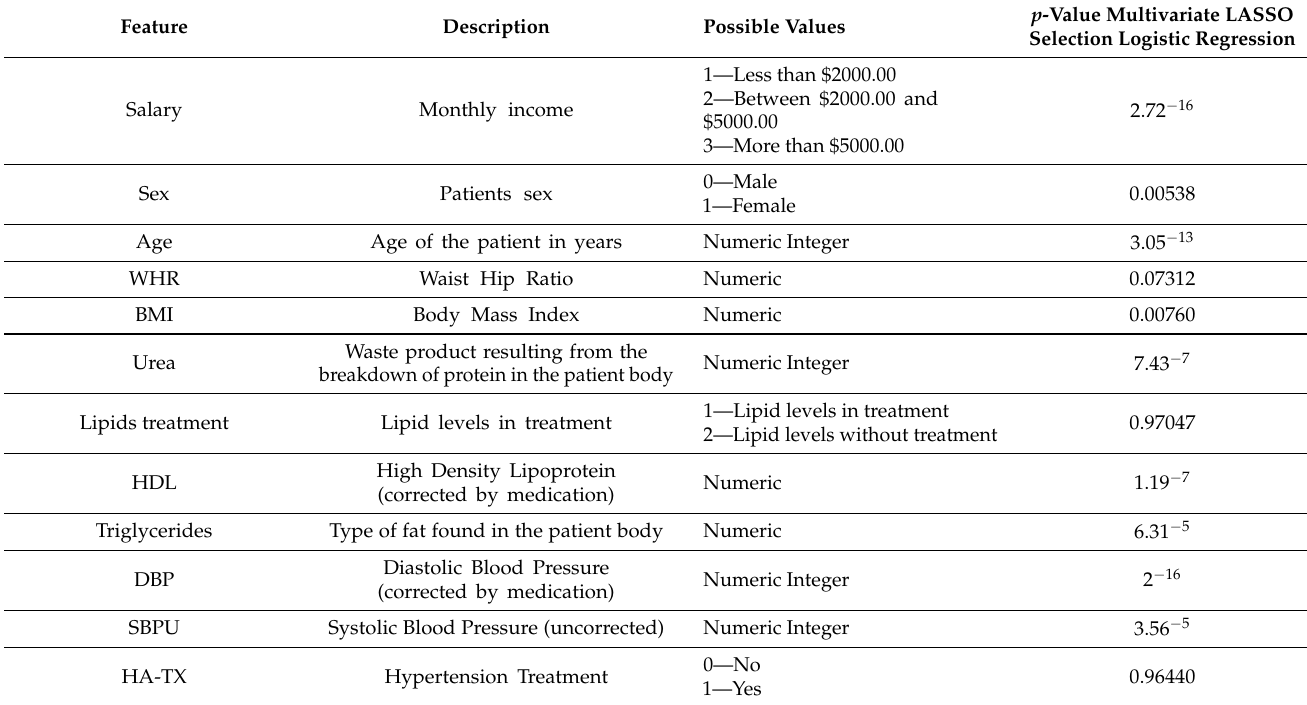
Table 3. LASSO result